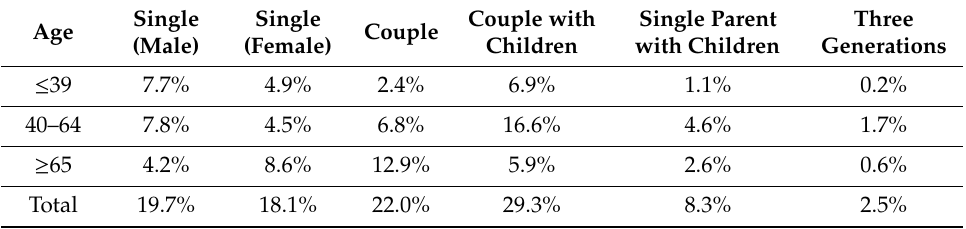
Table 1. Composition ratio of sample based on 2015 Population